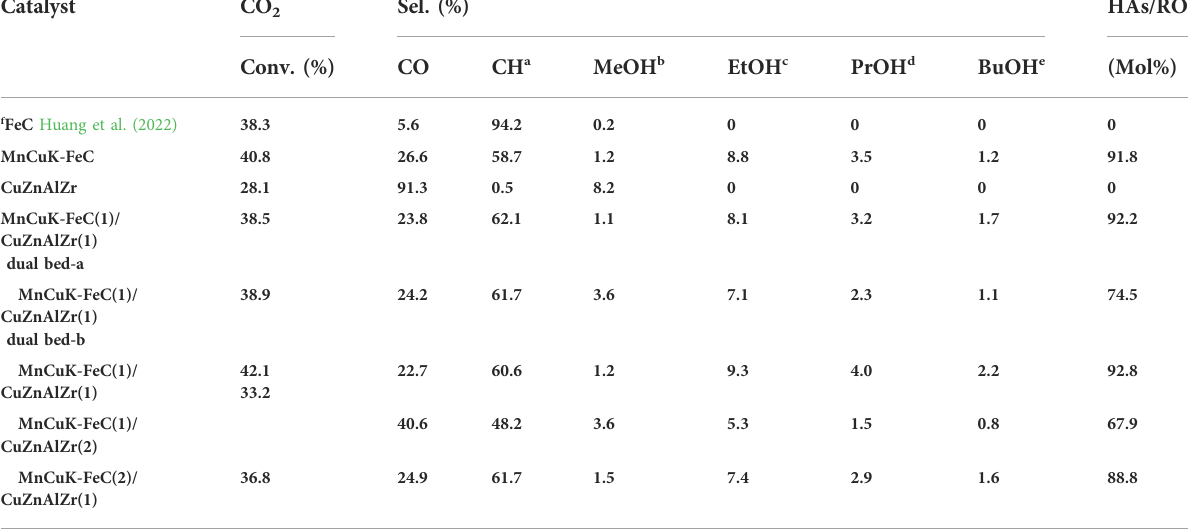
TABLE 2 CO 2 hydrogenation performance over the FeC-based catalysts and tandem catalysts.